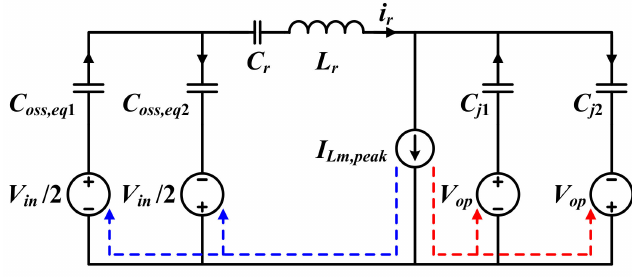
Figure 9. Equivalent circuit during